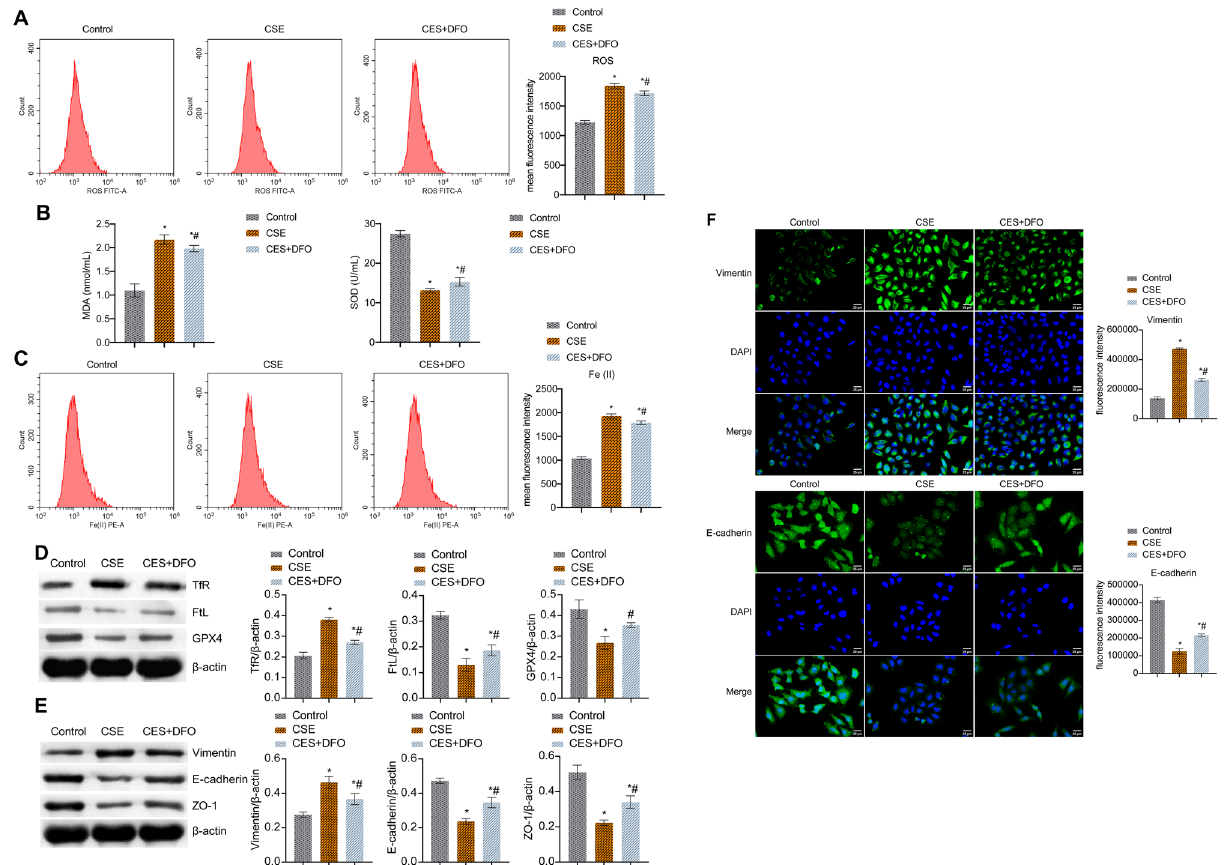
Figure 4. CSE-induced Ferroptosis promoted oxidative stress and EMT in BECs. ( A ) FCM detection of ROS content. ( B ) MDA and SOD levels. ( C ) The content of catalytic Fe (II) was detected by FCM. ( D ) The expression of ferroptosis markers TfR, FtL, and GPX4 was utilized by western blot. ( E ) The protein expression of EMT markers Vimentin, E-cadherin, and ZO-1. ( F ) IF staining of EMT markers Vimentin and E-cadherin. *P < 0.05 vs. Control, #P < 0.05 vs. CSE. The data were presented in the form of mean ± standard deviation. n =